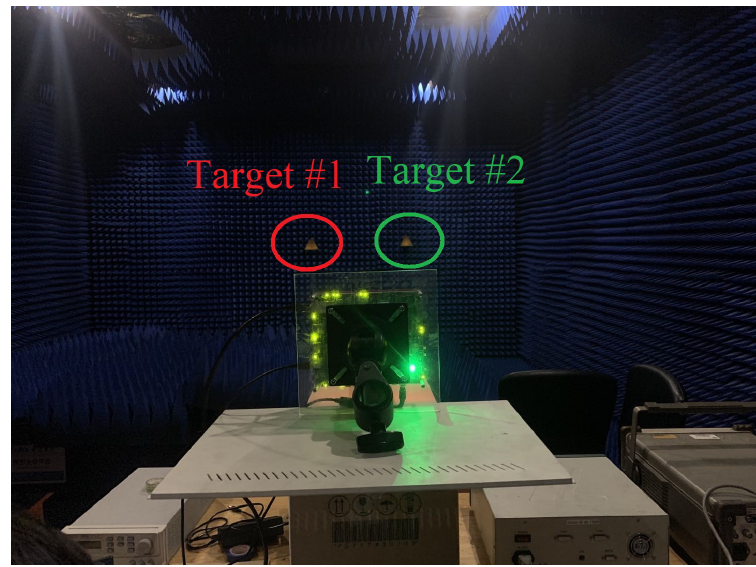
Figure 10. Double target scenario.